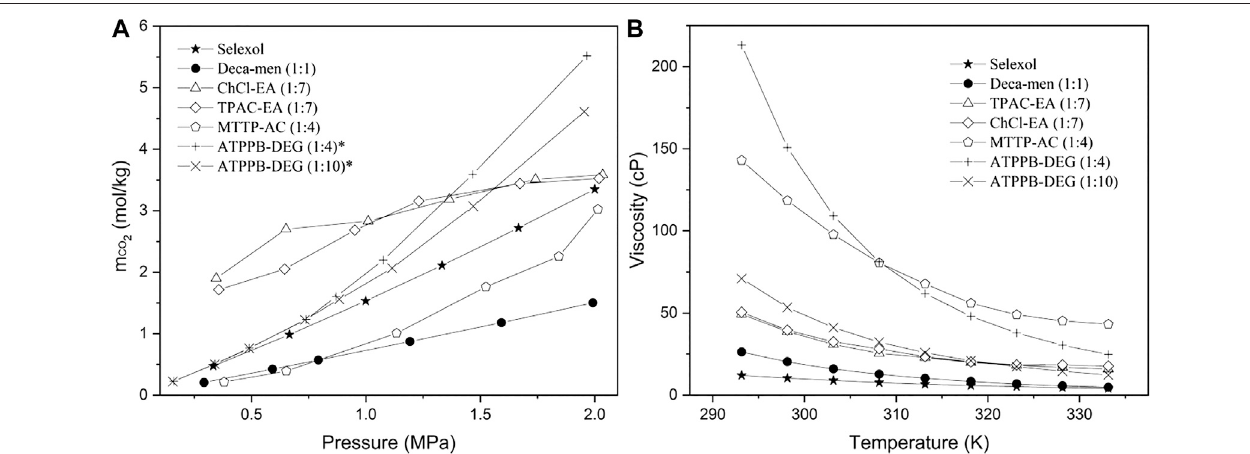
FIGURE 3 | (A) : CO 2 solubility as a function of pressure at 298.15 K (*absorption temperature of 303.15 K) and (B) : viscosity as a function of temperature at atmospheric pressure of Selexol and the DESs Deca-men (1:1), ChCl-EA (1:7), TPAC-EA (1:7), TPAC-EA (1:7), MTTP-AC (1:4), ATPPB-DEG (1:4), ATPPB-DEG (1:10).